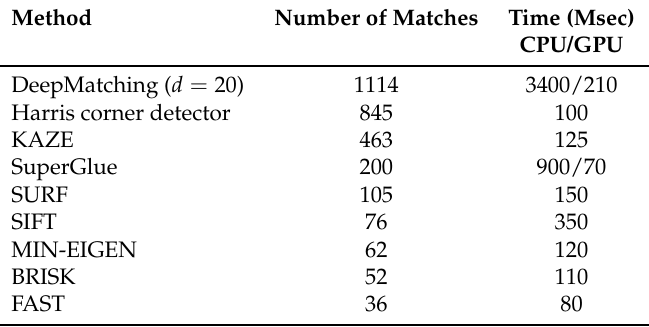
Table 3. Number of matches and running times obtained with each method. For the Deep learning-based methods, we also report the running times obtained in a GTX